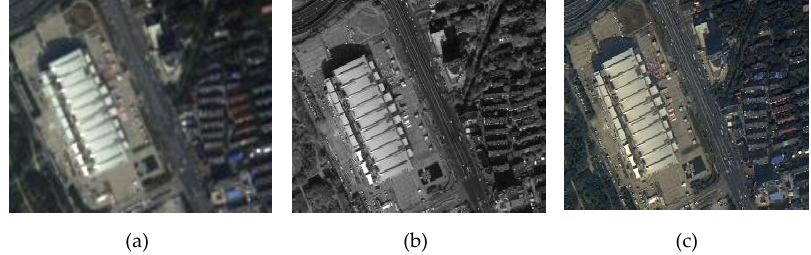
Figure 3. Remote sensing image. ( a ) Multispectral image; ( b ) Panchromatic image; ( c ) Fusion image based on nearest-neighbor diffusion pan-shaping algorithm.